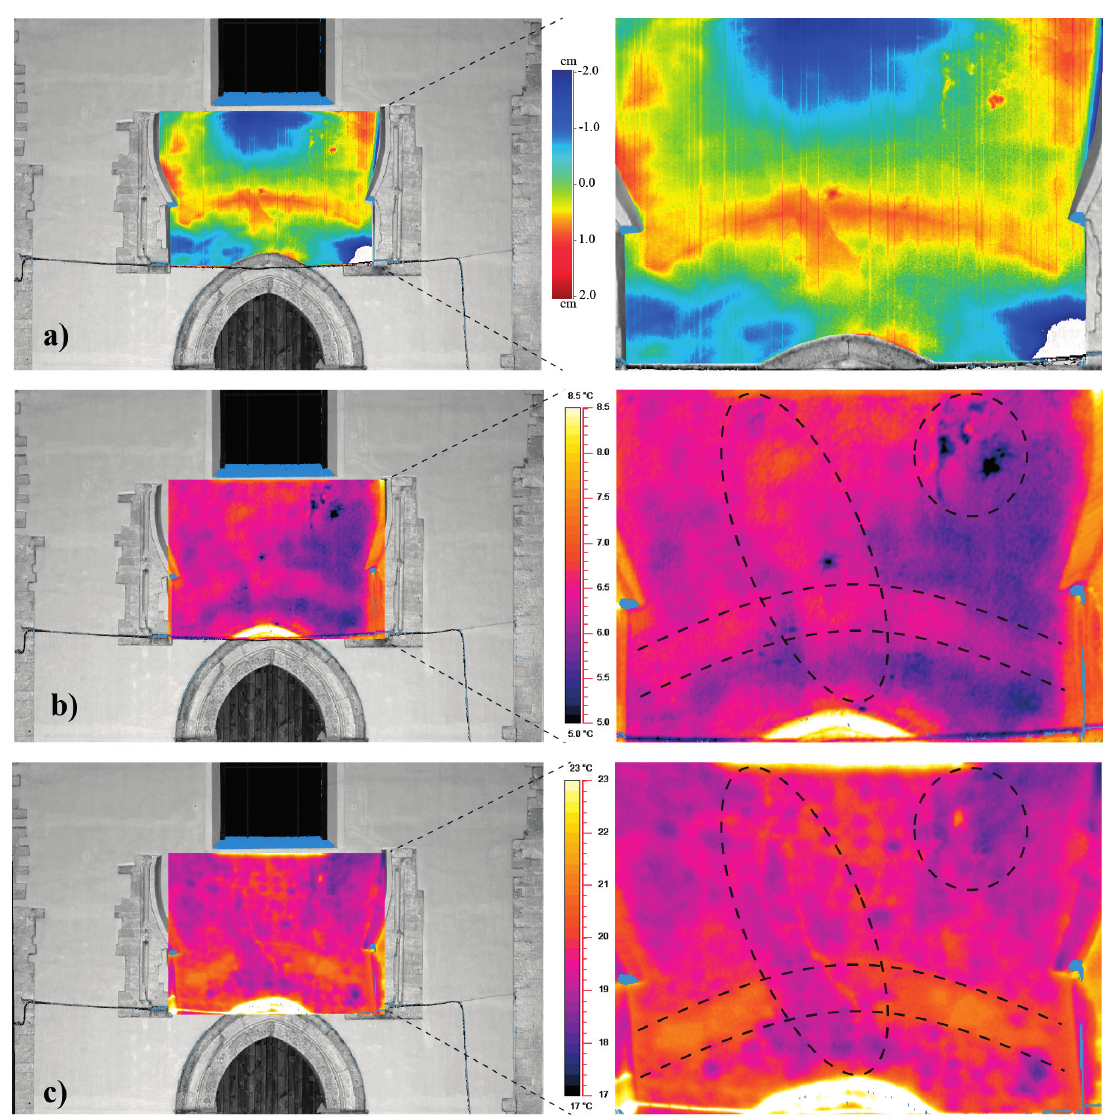
Figure 6. Particular of the façade of the church: ( a ) mesh by point cloud and map of the residuals with respect to a fitting plane; ( b ) image obtained in the evening of 4 December 2013 and ( c ) in the morning of 13 April